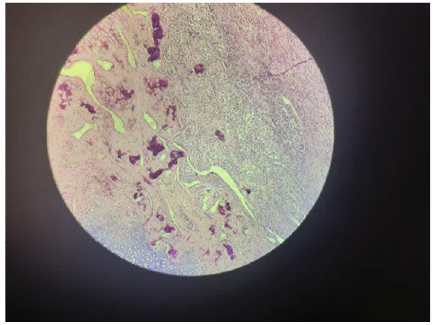
Figure 2: Coronal CT scan showing the involvement of IVC with the tumour thrombus.